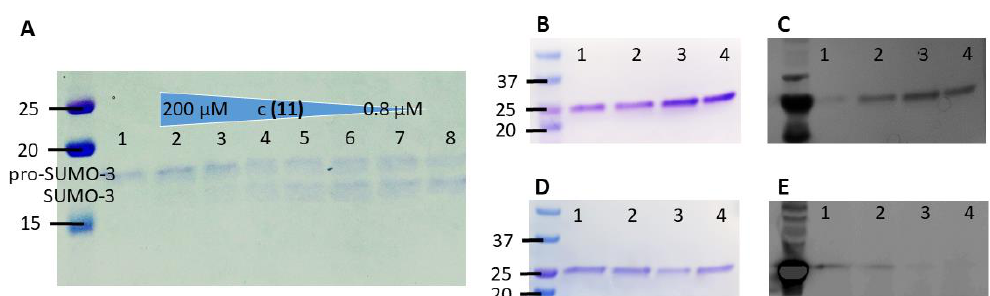
Figure 3. SDS page gels of the maturation of proSUMO3 ( A ) and photo crosslinking experiments with 56 on SENP1 ( B – E ). ( A ) Endopeptidase inhibition of 11 against the maturation of proSUMO3 (c = 5 µ M) with SENP1 (200 nM) incubated at 37 ◦ C for 1 h. 1: no SENP1 added; 2–7: 3-fold dilution of 11 starting at 200 µ M and final concentration of 0.8 µ M; 8: no 11 added; ( B , C ) crosslinking experiments of 56 (200 µ M) with SENP1 (10 µ M) followed by CuAAc of the crosslinked probe to azide-fluor 545. 1: no UV irradiation 2–4): UV irradiation for 30 min; ( D , E ) crosslinking competition experiment of 56 (200 µ M) with SENP1 (10 µ M) followed by CuAAc of the crosslinked probe to azide-fluor 545. 1–2: no competitor inhibitor, 3–4: 11 (400 µ M) was added. SDS gels were visualized by Coomassie blue stain ( B , D ) and fluorescence (Ex. 520 nm; Em. 575 nm) ( C , E ).